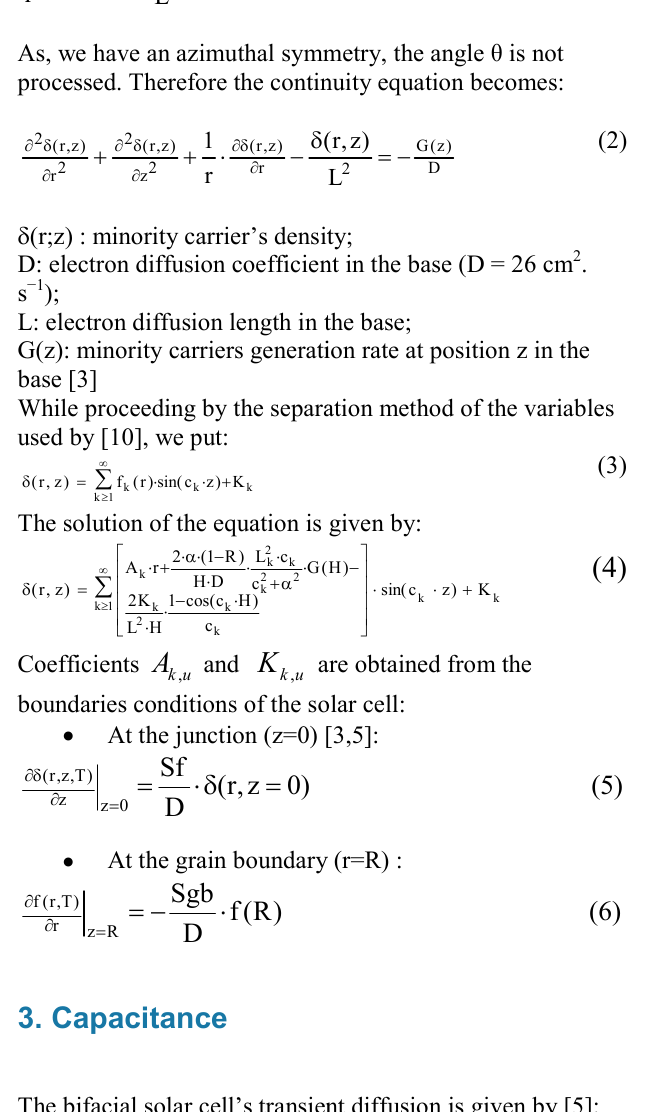
Figure 1. Isolated cylindrical grain The bifacial solar cell is assumed to have four zones: the emitter doped N + , the base doped P, the junction